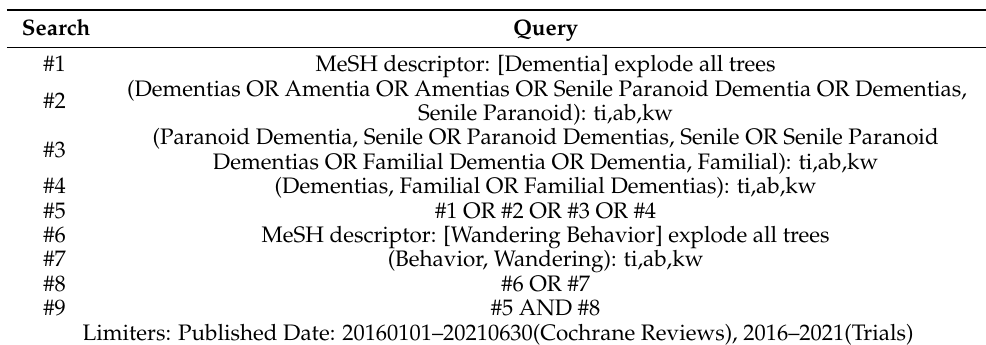
Table A5. The Cochrane Library search strategy. Search